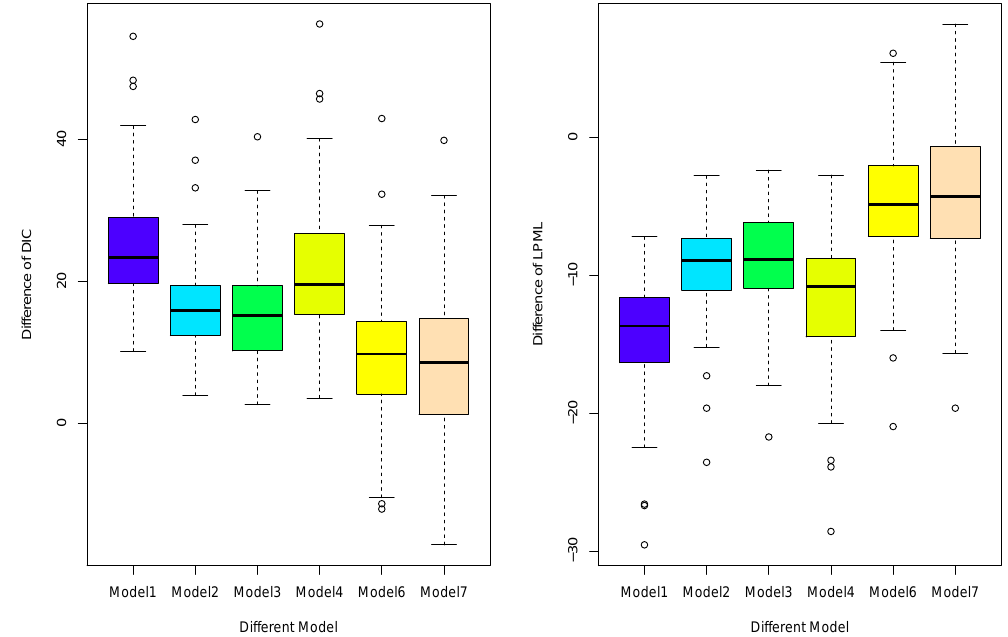
Figure 3. DIC and LPML difference between candidate models and true model (model 5) of Simulation 2 (( left ) DIC, ( right )